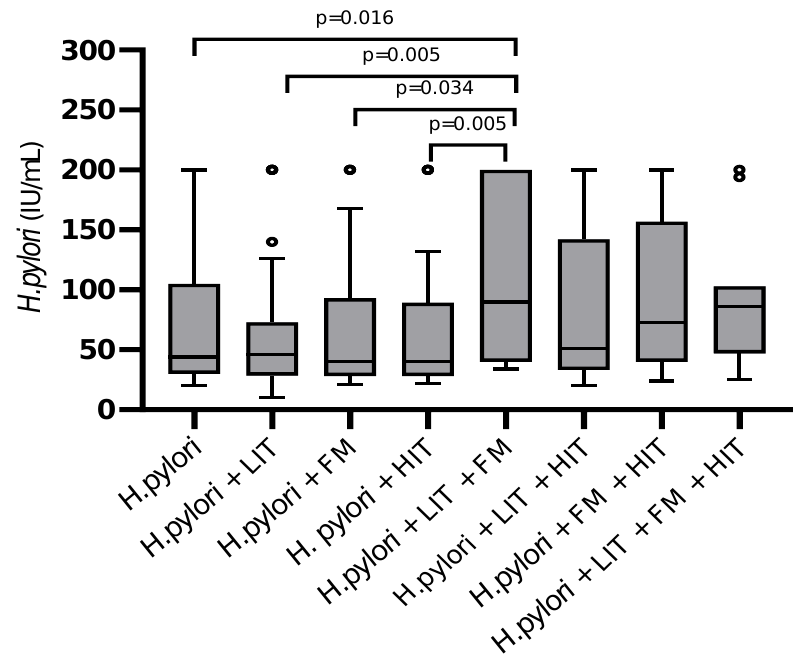
Figure 3: In 262 patients IgA antibodies against H. pylori were detected with enzyme-linked IgA im- munosorbent assay . Included are 63 patients with H. pylori only, 45 patients H. pylori combined with LIT, 19 H. pylori and FM patients, 46 H. pylori with HIT, 19 were H. pylori patients with LIT and FM, 44 were H. pylori and LIT with HIT patients, 15 H. pylori , FM and HIT and 11 H. pylori , LIT, HIT with FM